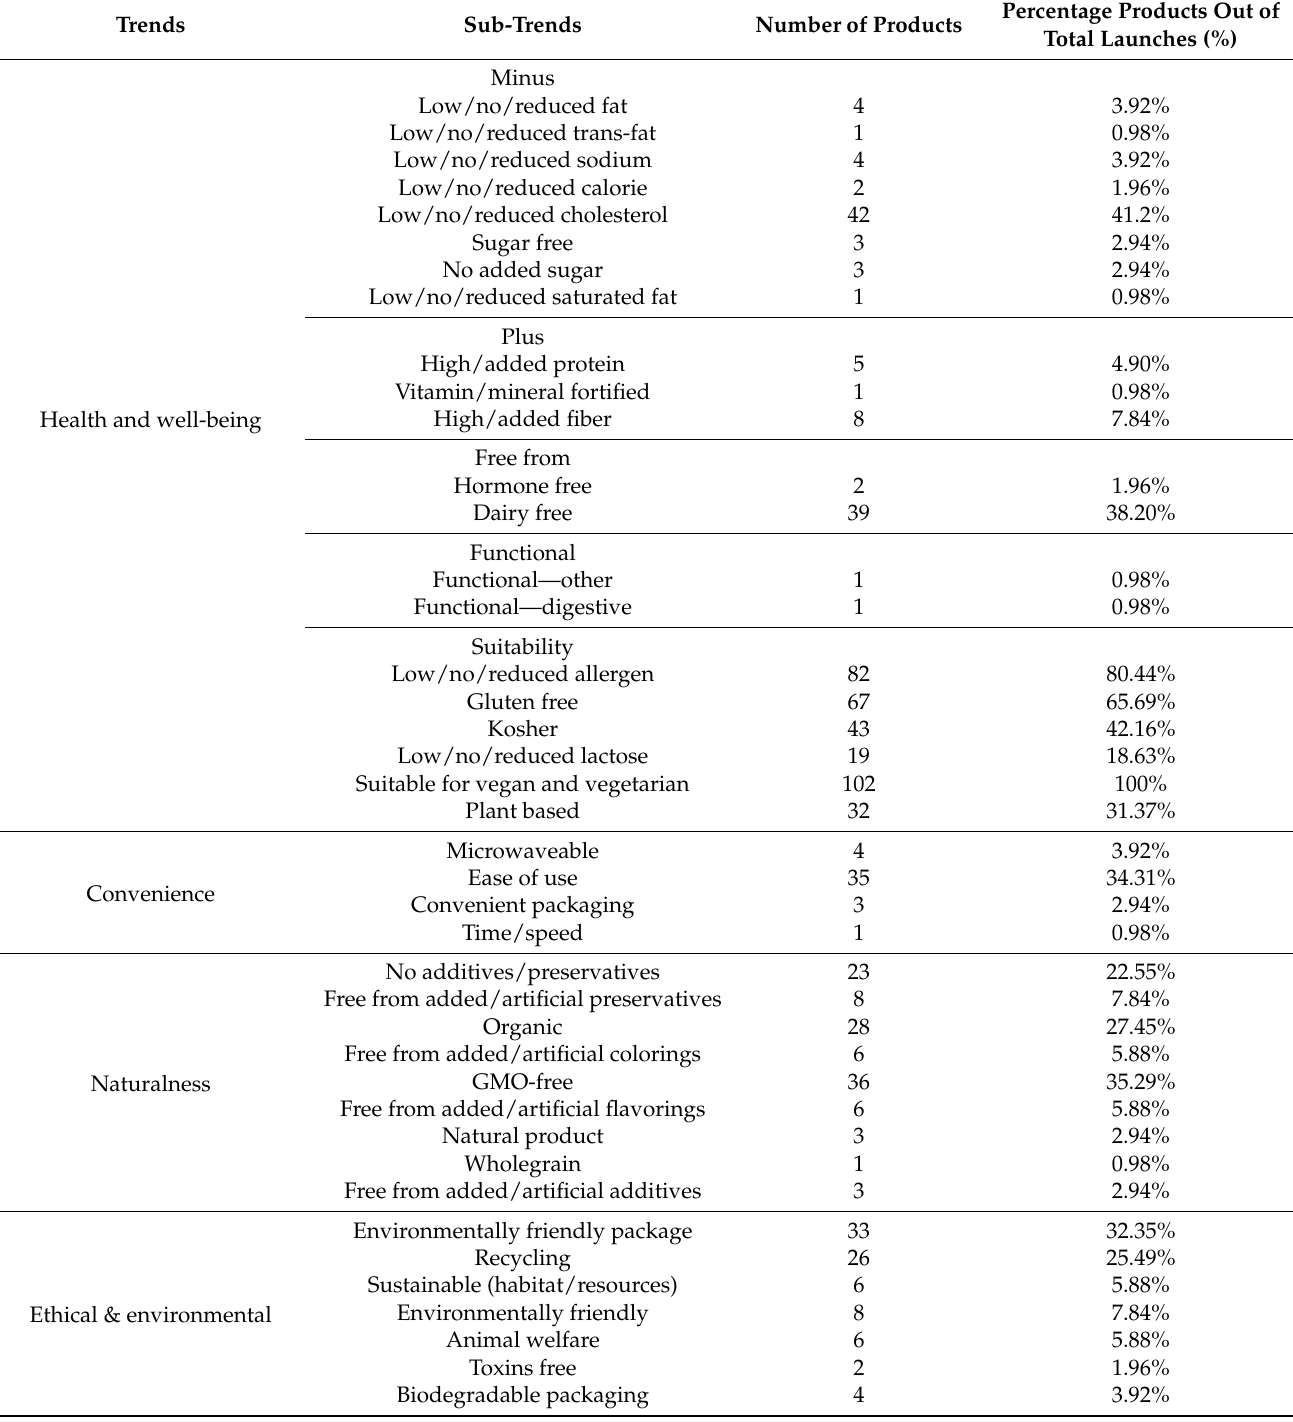
Table 1. Current trends in vegan eggs launched in the global market (2016–2021) 1